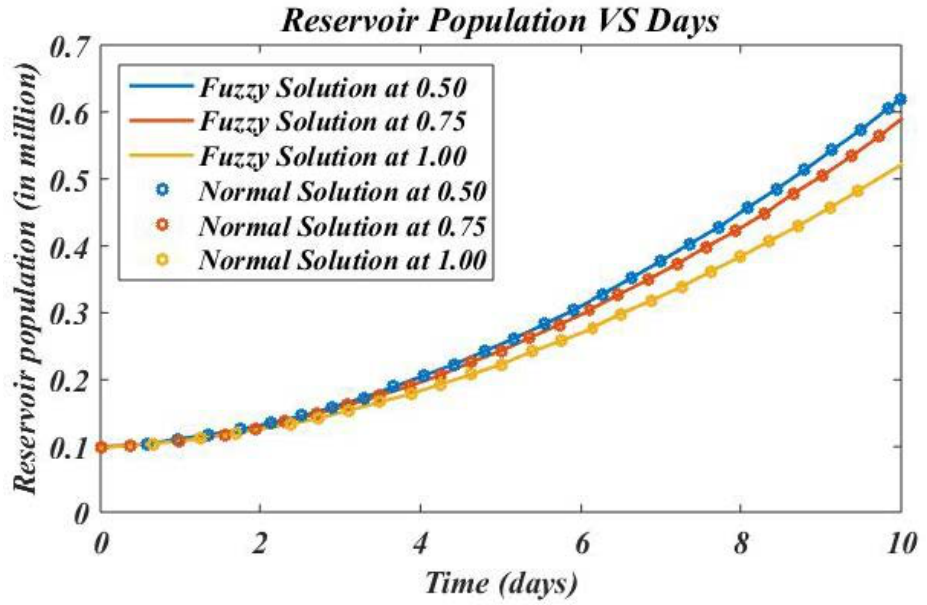
Figure 6. Illustration of approximate fuzzy and normal reservoir compartment solutions for three terms at given uncertainty levels ϑ ∈ [ 1,2 ] versus fractional